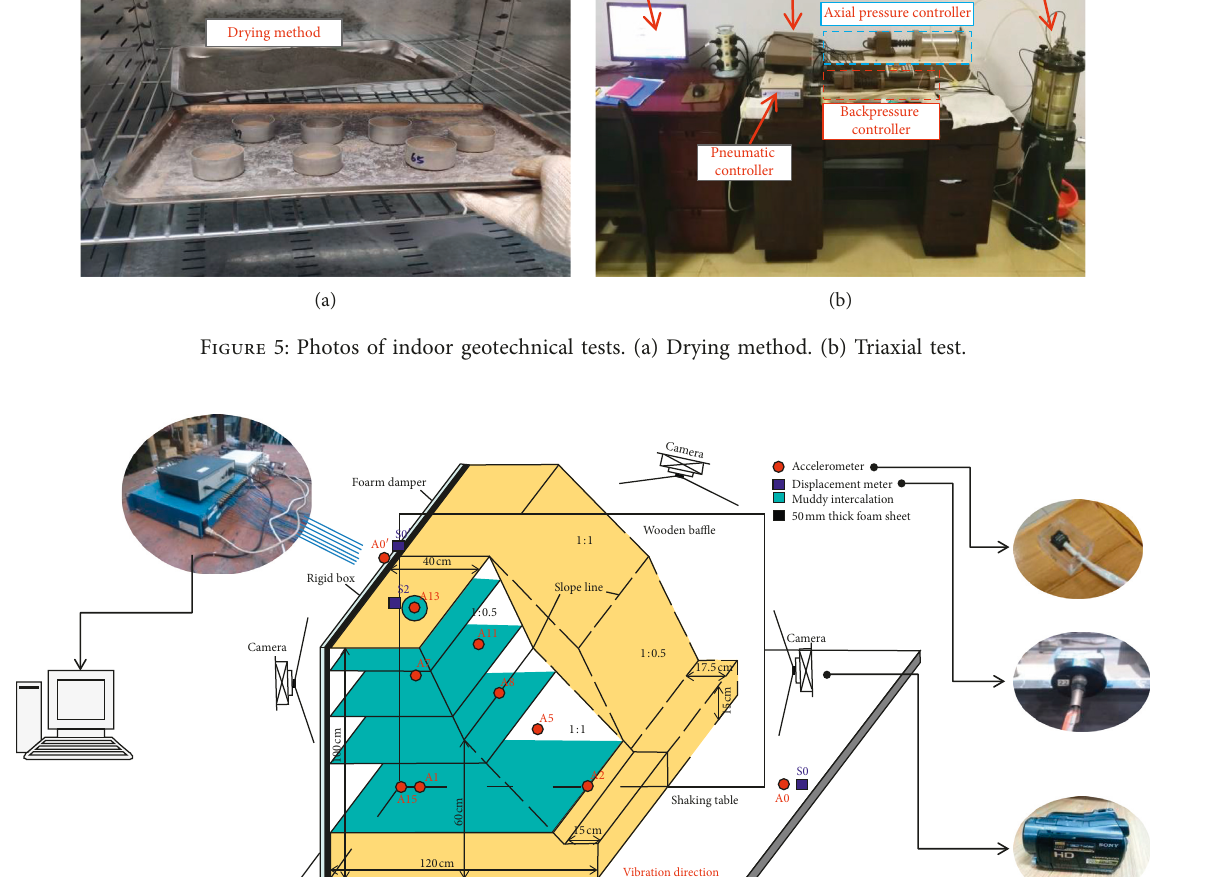
directionShaking Vibration